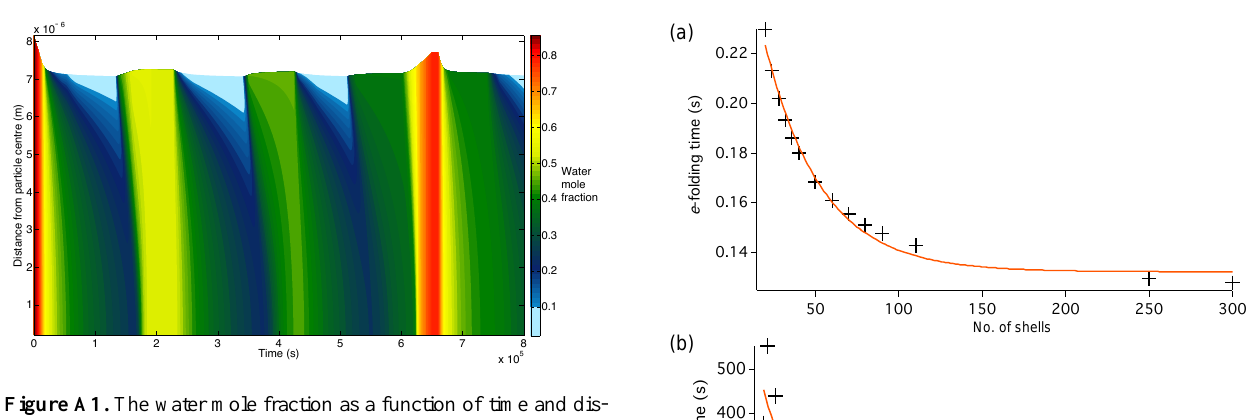
Figure A1. The water mole fraction as a function of time and dis- tance through a single particle using the ETH model and the same inputs as for Fig. 3 of Zobrist et al. (2011).